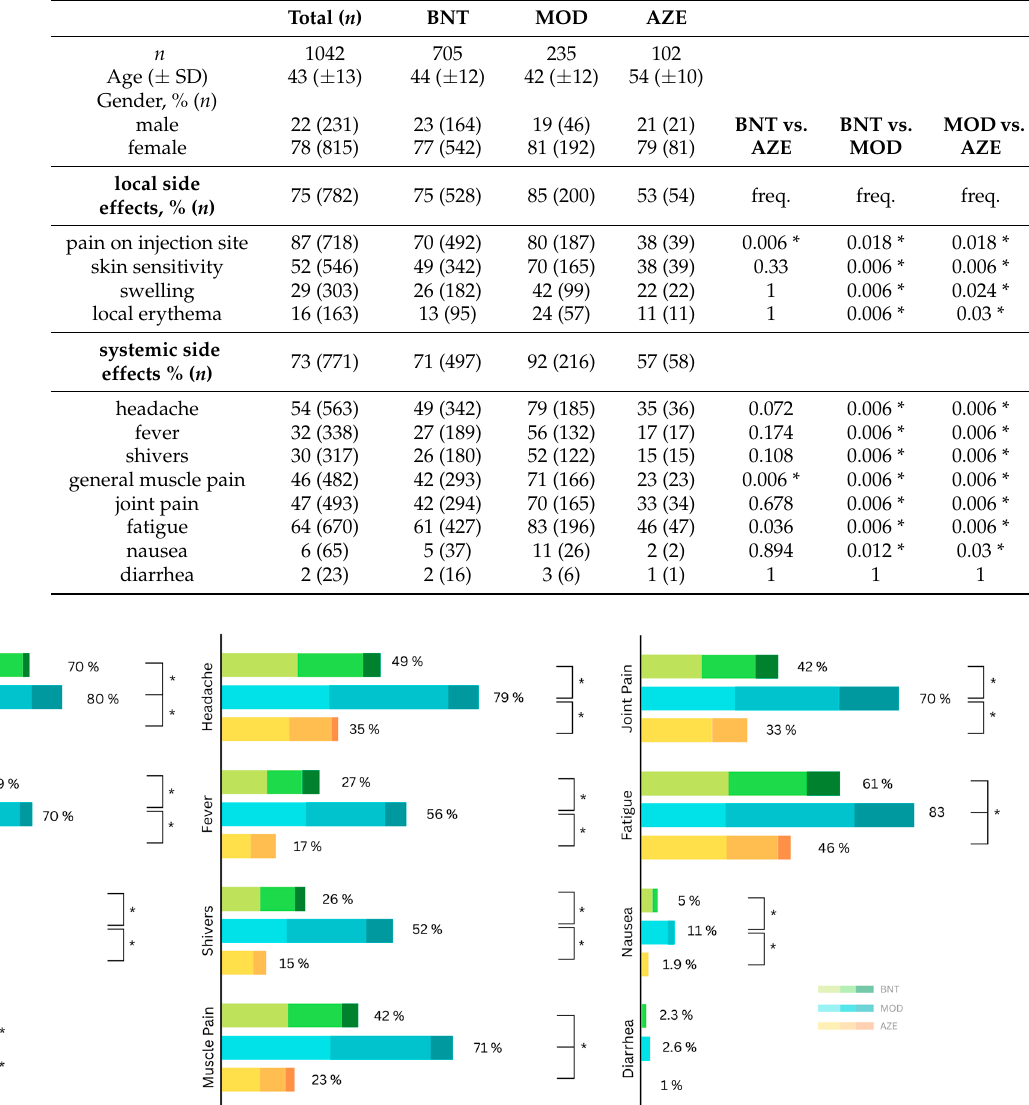
Table 4. Acute local and systemic side effects after the second vaccination. p -values for the comparison of different vaccines in terms of side effect frequency and severity. A Chi-square test was performed for the administered vaccine after the first vaccination and the proportion of each reported side effect. p -values were adjusted with the Bonferroni correction (6 × ). Asterisks indicate statistical significance. (AZE: AstraZeneca (ChAdOx1 nCov19); BNT: Biontech/Pfizer (BNT162b2); MOD: Moderna (mRNA-1273)).